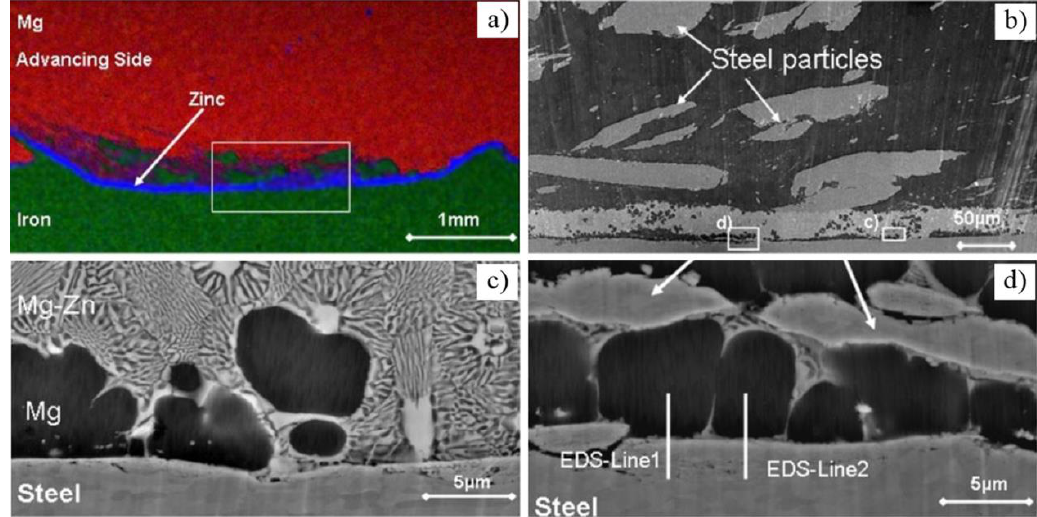
Figure 3. FSW Mg/Zn coated steel process [20] ( a ) EDX map of cross-section; ( b ) stir zone near Mg/steel interface; ( c , d ) enlarged drawing in ( b ).